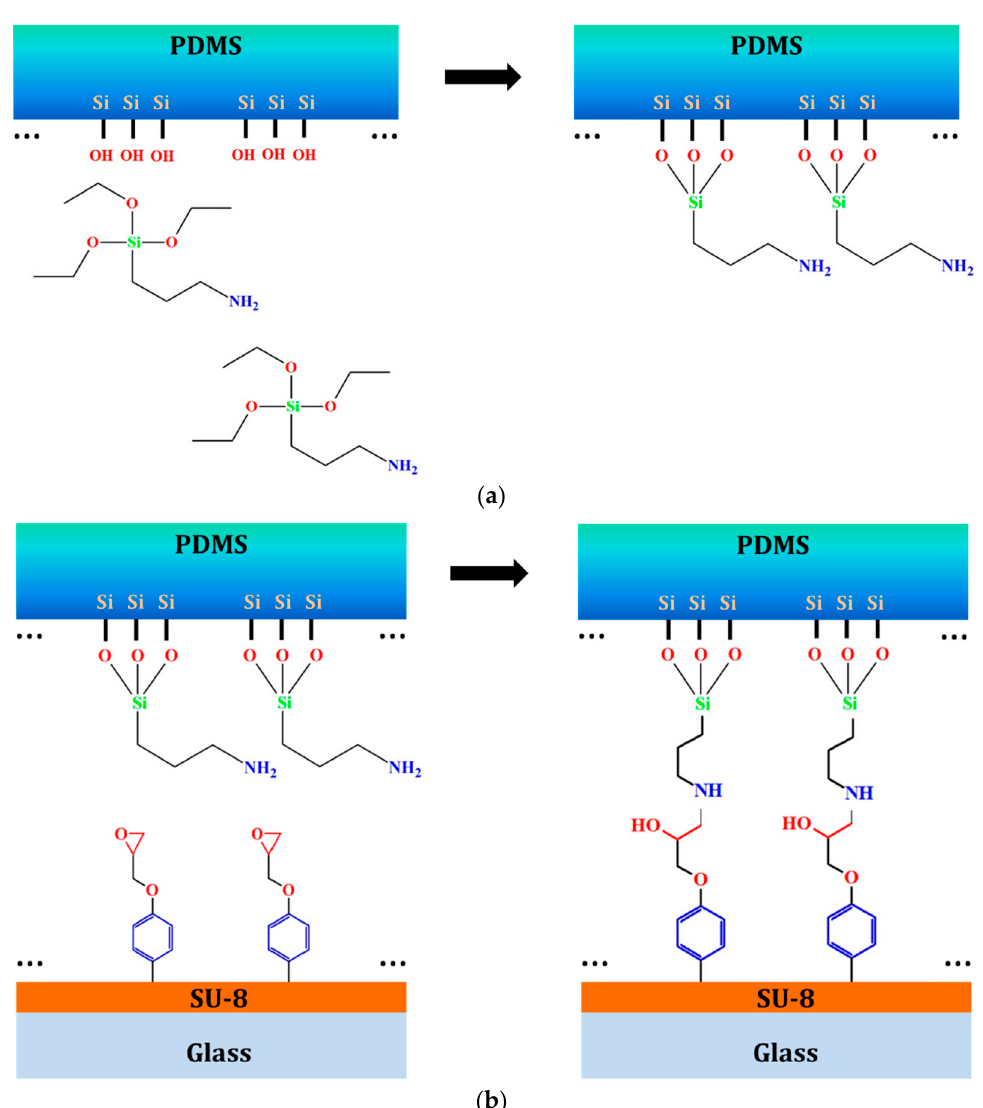
Figure 1 . Theoretical reactions during the bonding. ( a ) Reaction between APTES molecule and the O 2 plasma activated PDMS surface and ( b ) reaction between the -NH 2 group from the APTES molecule on the PDMS surface and the epoxy group from the SU-8 surface.